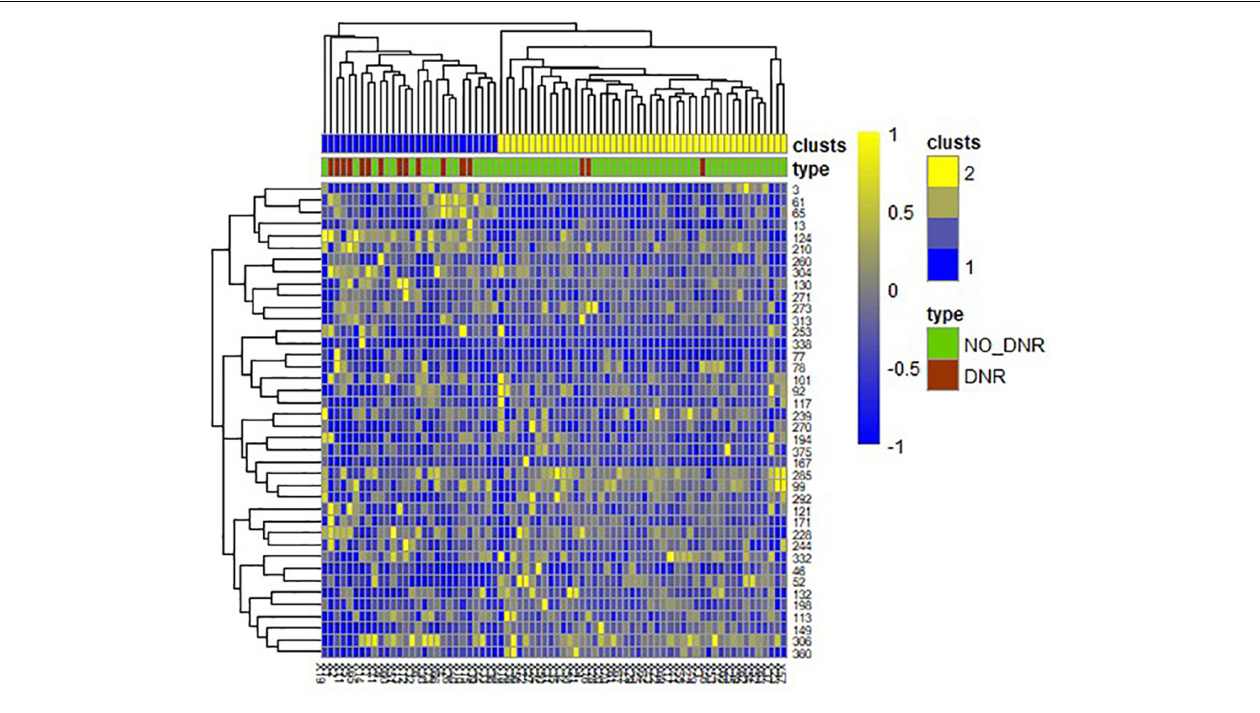
FIGURE 4 | Unsupervised clustering heat map of the selected 40 features. Rows represent features, columns represent samples. In the first two rows, blue and yellow represent the results of automatic clustering of samples, and red and green represent the true categories of samples.